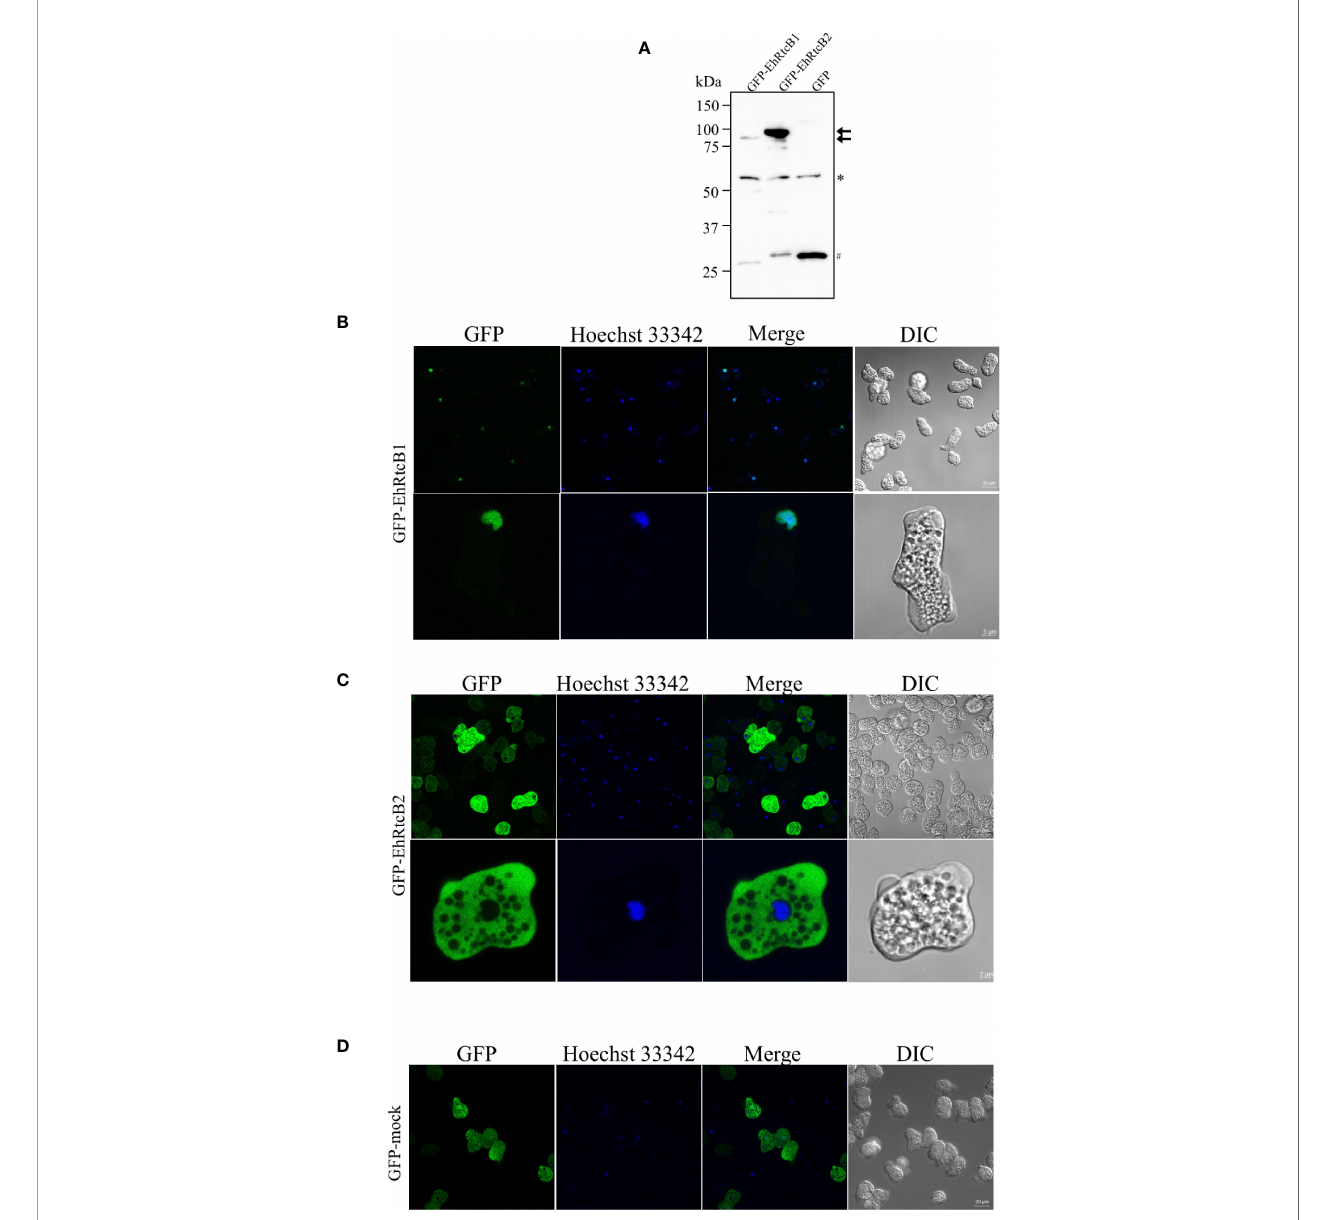
FIGURE 4 | Expression and intracellular localization of GFP-fused EhRtcB1 and EhRtcB2. (A) Expression of GFP-RtcB1 and GFP-RtcB2 veri fi ed by SDS-PAGE and immunoblot analysis. Cell lysates from the transformant strains that expressed GFP-RtcB1 (86.5kDa) or GFP-RtcB2 (88.1kDa), cultivated with 20 m g/ml G418, were subjected to 10% SDS-PAGE and immunoblot analysis using anti-GFP antibody. Arrows indicate the untruncated GFP-EhRtcB1 and GFP-EhRtcB2. An asterisk indicates about 55 kDa non-speci fi cally reacted unknown protein, while a sharp mark (#) indicates the fragments around 26 kDa corresponding to GFP, which were likely produced by cleavage of the fusion proteins. (B – D) Microscopic images of the amebic trophozoites expressing GFP-EhRtcB1 (B) , GFP-EhRtcB2 (C) , and GFP- Mock (D) . Images of live un fi xed trophozoites stained with Hoechst (for nuclear DNA staining) captured by LSM 780 confocal microscope are shown with a low (upper panels) and high magni fi cation (lower panels). GFP, Hoechst, merged, and differential interference contrast (DIC) images are